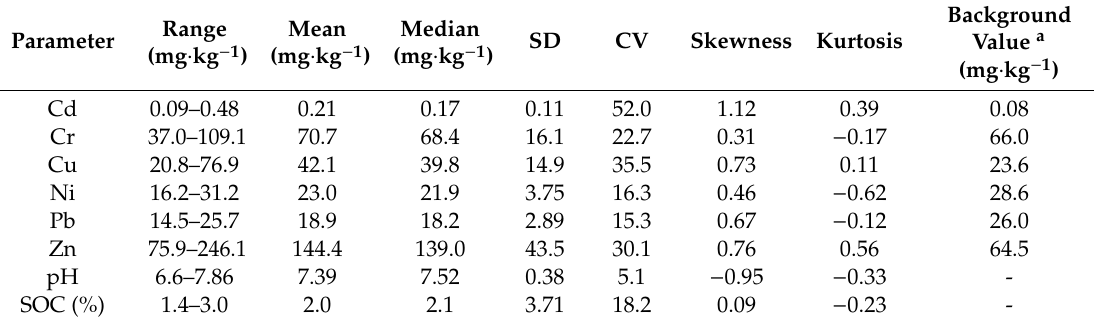
Table 2. Descriptive statistics for soil properties and HM contents in the study